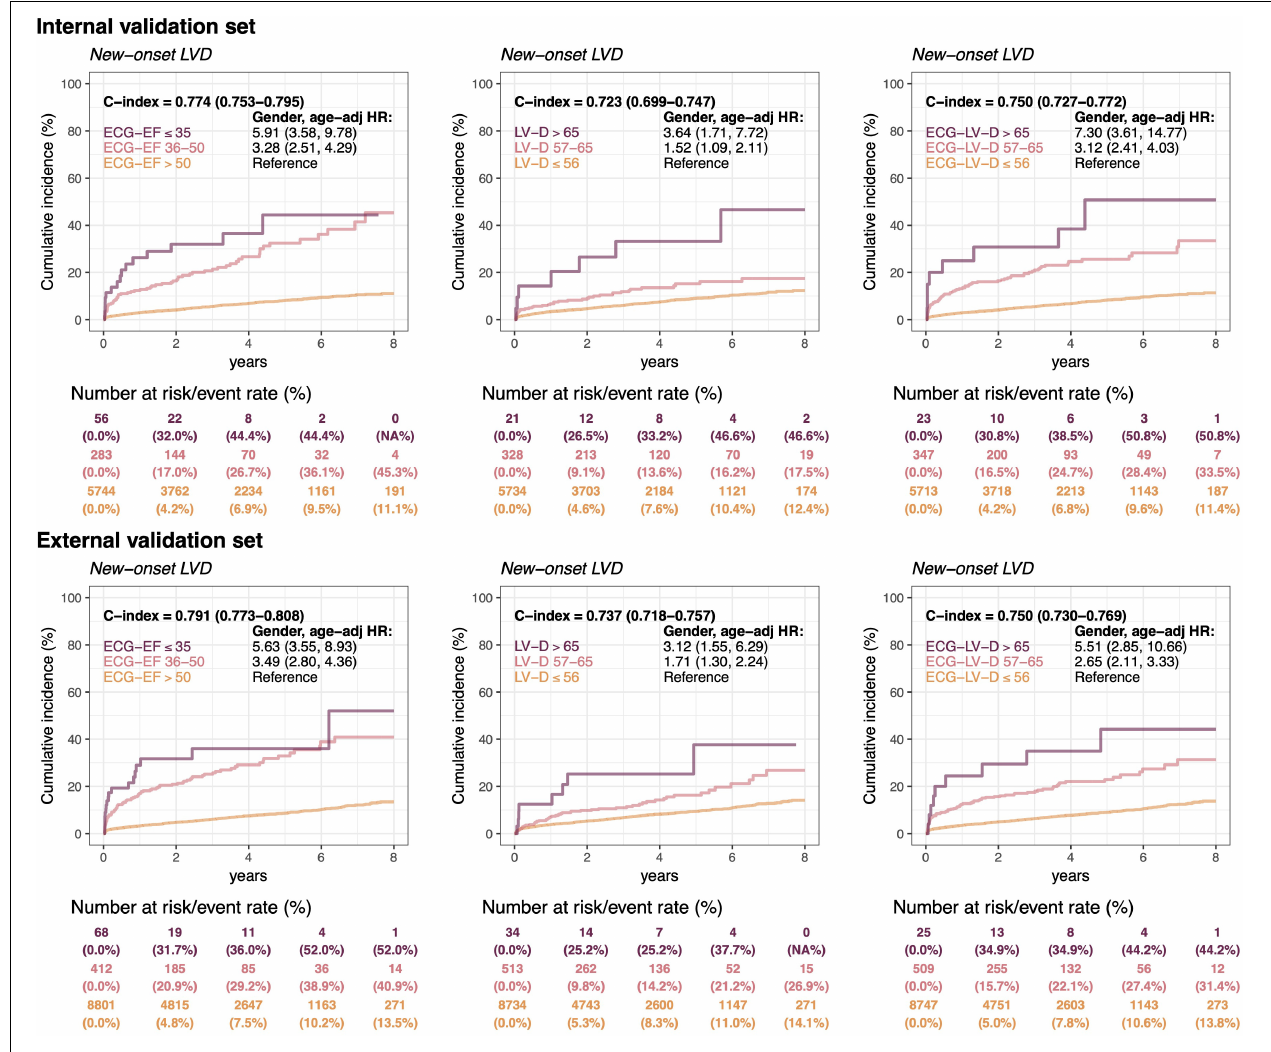
FIGURE 7 | Long-term incidence of developing a new-onset left ventricular dysfunction (LVD, EF ≤ 35%) in patients with an initially normal EF (EF > 50%) stratified by ECG-EF, LV-D, and ECG-LV-D. The C-index is calculated based on the continuous value combined with sex and age. The analyses are conducted both in internal and external validation sets. The table shows the at-risk population and cumulative risk for the given time intervals in each risk